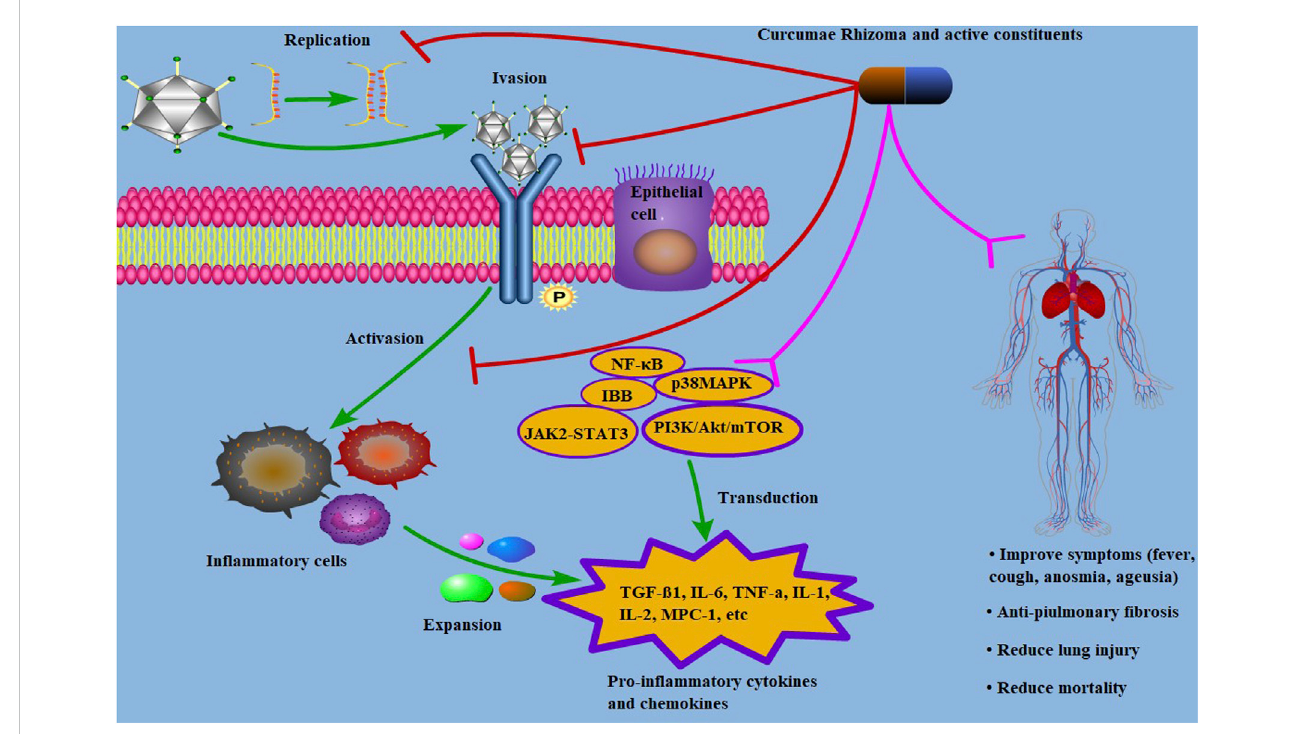
Mechanism of Curcumae Rhizoma and its active constituents against COVID-19. Antiviral mechanism of Curcumae Rhizoma and its active constituents in treating with COVID-19. Curcumae Rhizoma and its active constituents exhibit effects on COVID-19 by “ multi-component, multi-target, multi-pathway ” . The steps include preventing viral replication and invasion, suppressing the activations of in fl ammatory cells, and regulating the signaling pathways by acting on the targets, leading to improvement of respiratory